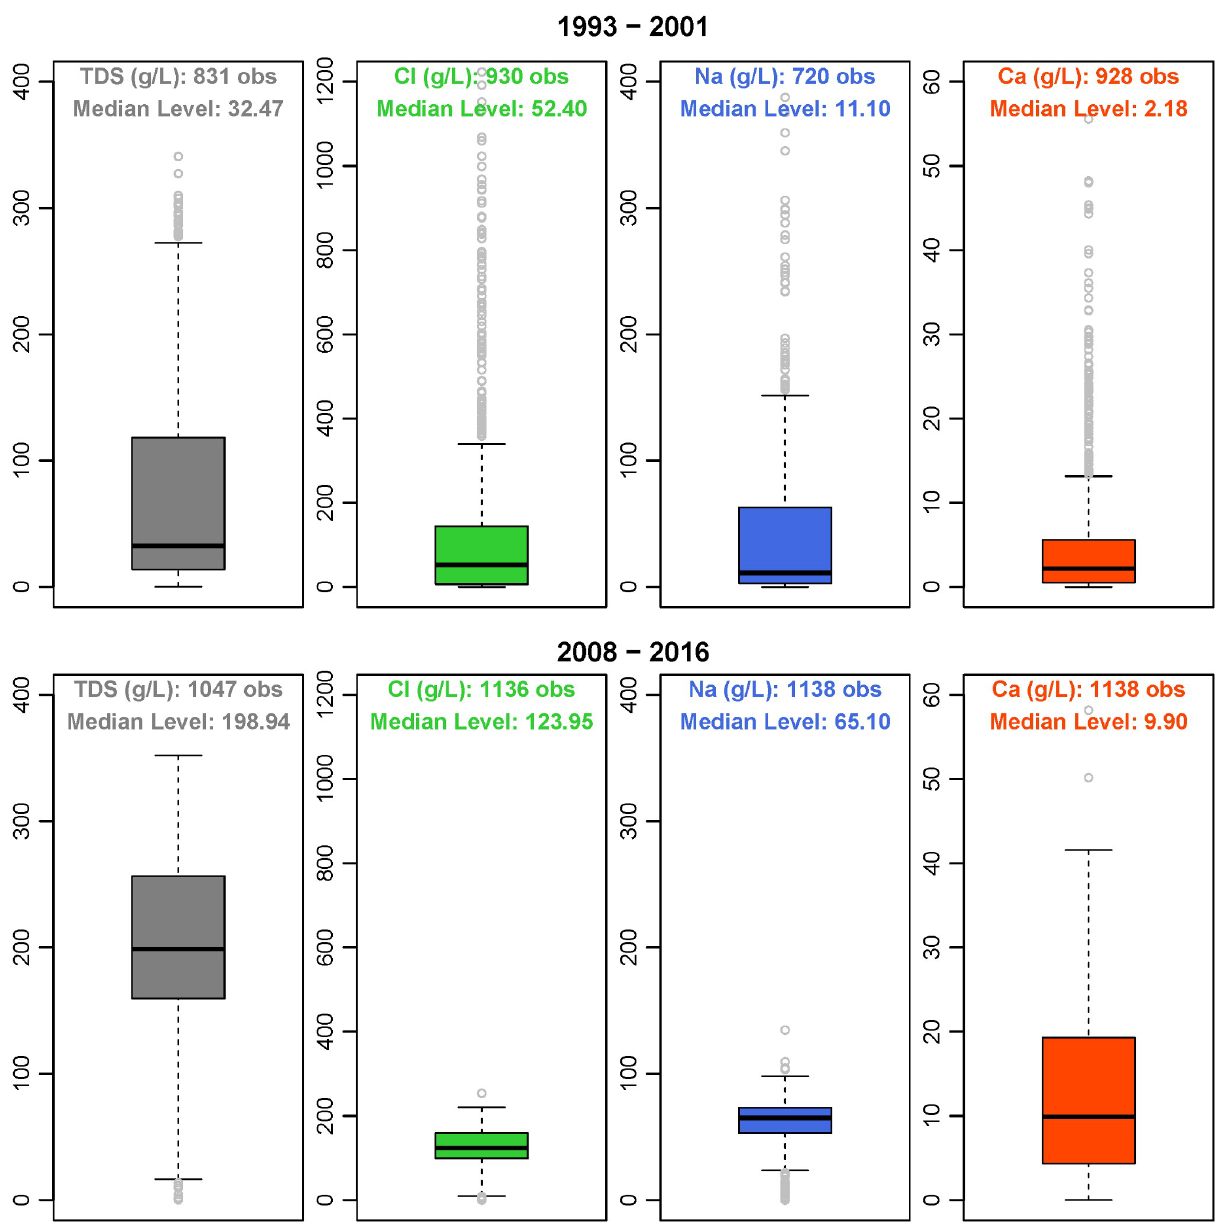
Fig 4. The levels of TDS, chloride, sodium, and calcium before (1993–2001) and after (2008–2016) the shale boom. Note: The author produced the figure in